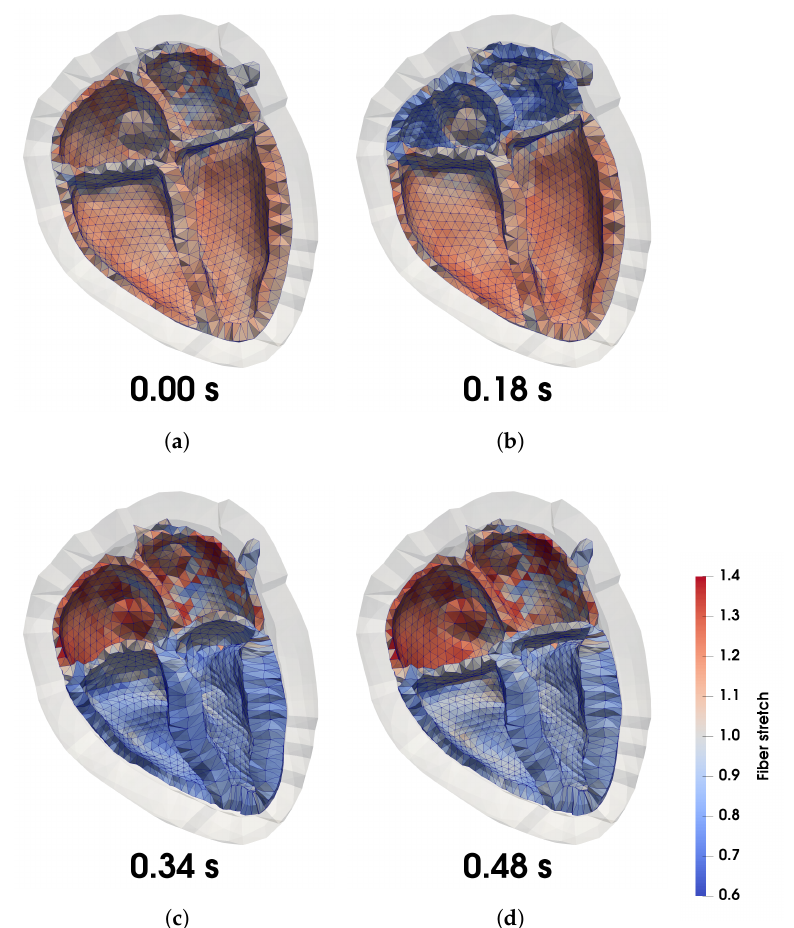
Figure 9. Snapshots of the deformation of the heart during the final cycle. Visualized is the stretch in fiber direction γ f in a clipped long axis four chamber view. ( a ) at rest; ( b ) end-diastole; ( c ) end-systole; ( d ) end of isovolumetric